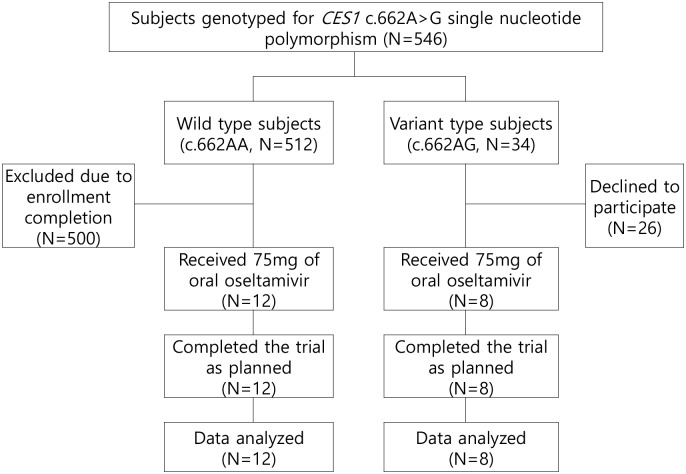
Study flowchart.